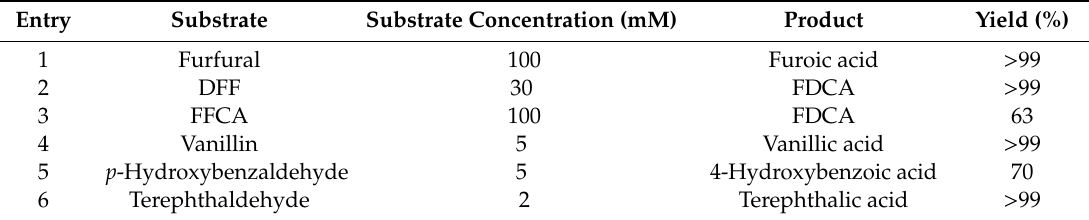
Table 2. Whole-cell biocatalytic oxidation of aldehydes.